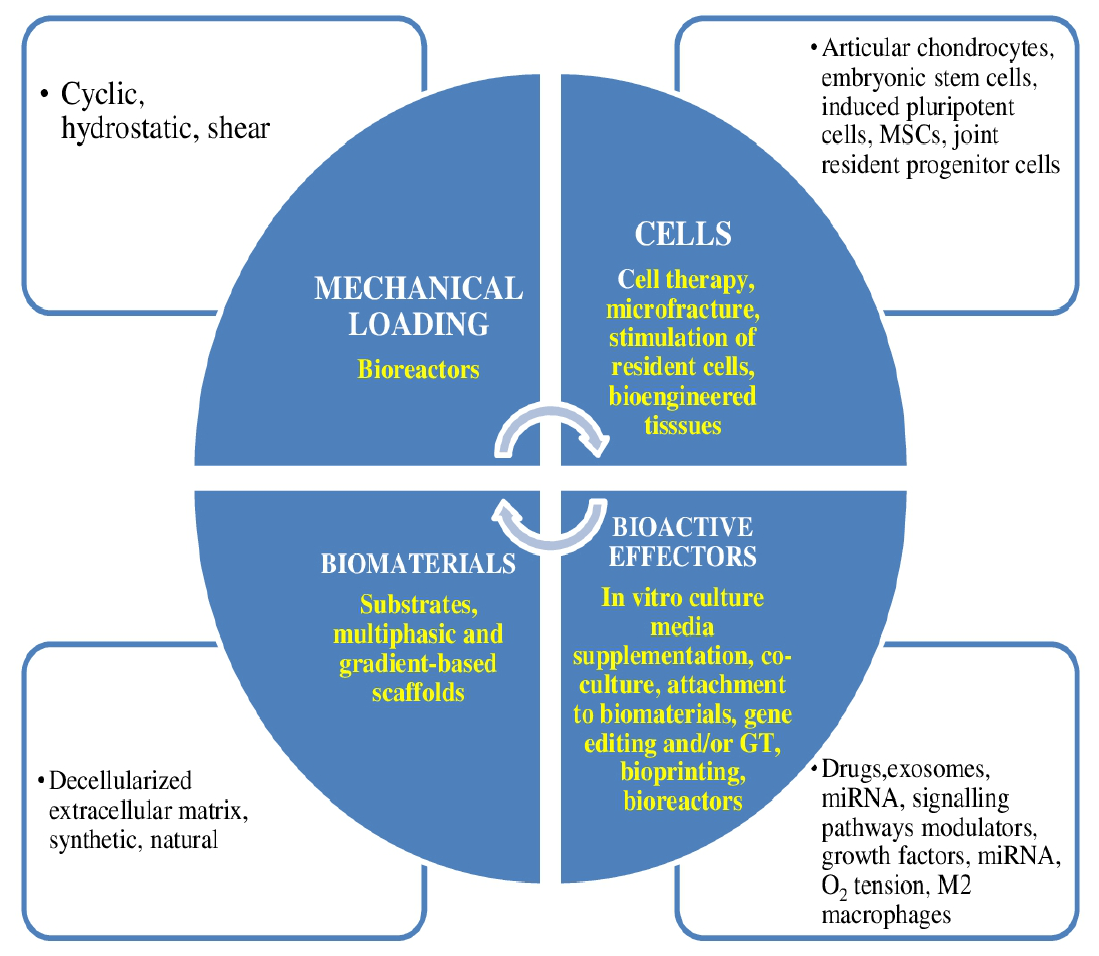
Figure 2. Elements implicated in cellular therapy and tissue engineering for the repair of cartilaginous tissue. Therapies for cartilage repair need any compound of cells, biomaterials, mechanical loading, and/or bioactive effectors. In yellow, the four main ways in which they can be used for cartilage tissue engineering are shown. MSCs = mesenchymal stem cells.